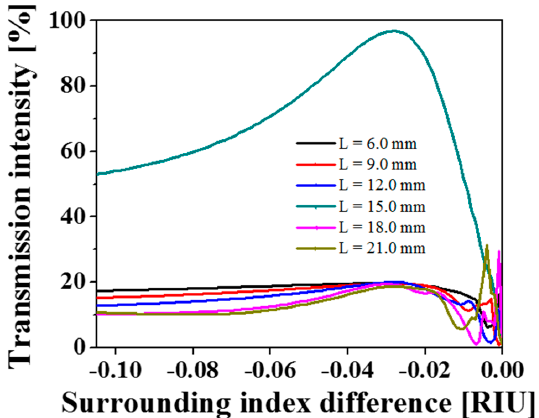
Figure A1. Transmission curves with respect to the surrounding RI for different interaction lengths.